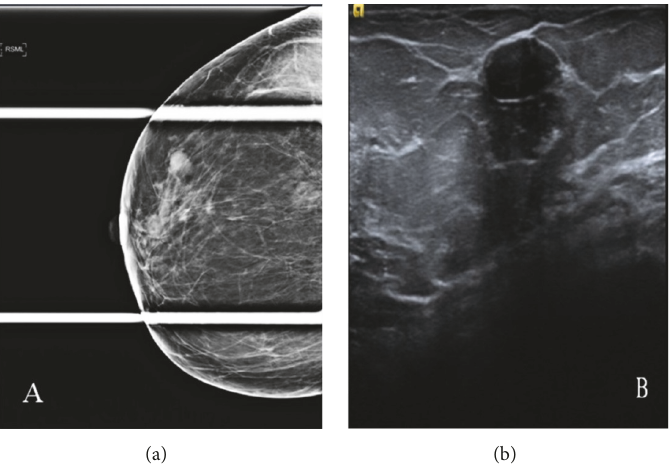
Figure 2: 53-year-old woman presenting for evaluation of a palpable mass. (a) Spot compression view at the site of the palpable abnormality shows an oval circumscribed equal density mass. (b) Ultrasound confirms an oval circumscribed hypoechoic mass with parallel orientation. A biopsy was recommended in view of the new palpable finding. The mass remained stable at follow-up after 18